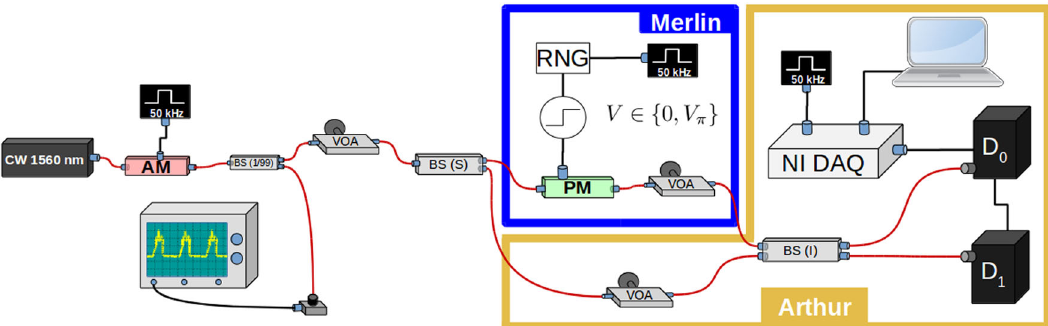
Fig. 3 Experimental setup. A coherent light source operating at a wavelength of 1560 nm (Pure Photonics) together with an amplitude modulator (AM) are used to generate coherent pulses at a 50 kHz repetition rate and with a 10 ns pulse duration. Using a beam splitter with 1/99 ratio, we monitor the pulse power with a photodiode and send the small fraction of the beam to the rest of the setup. The beam is further attenuated before being split with a balanced beam splitter (BS) and sent to Merlin and Arthur. The former encodes the proof in the phases of his pulses using a phase modulator (PM). They both use attenuators to fi ne tune and equalize the photon number in their paths and the pulses are then interfered on the output beam splitter (I) before been detected by InGaAs avalanche photodiode single-photon detectors (IDQuantique). The measurement outcomes are collected using a